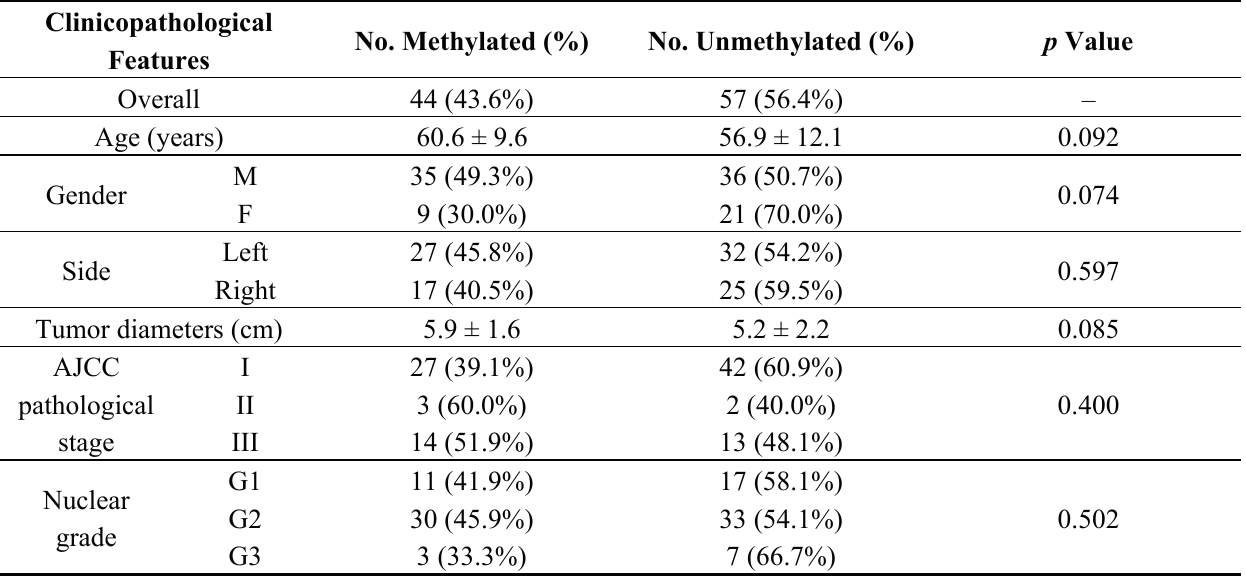
Table 1. Clinicopathological features of ccRCC patients and ADAMTS18 gene methylation